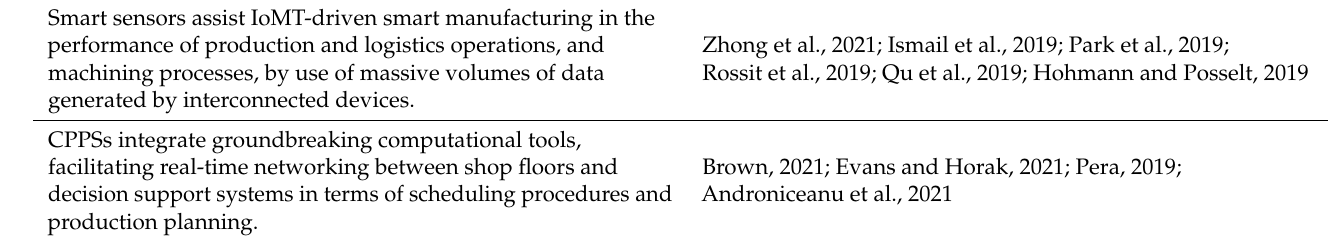
Table 4. Synopsis of evidence regarding analyzed topics and descriptive outcomes (research